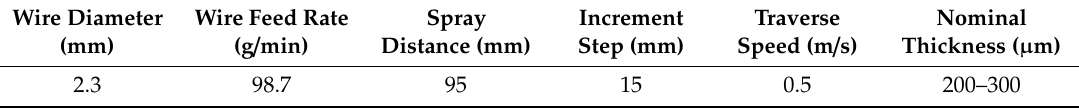
Table 2. Spray parameters used for the coating production.